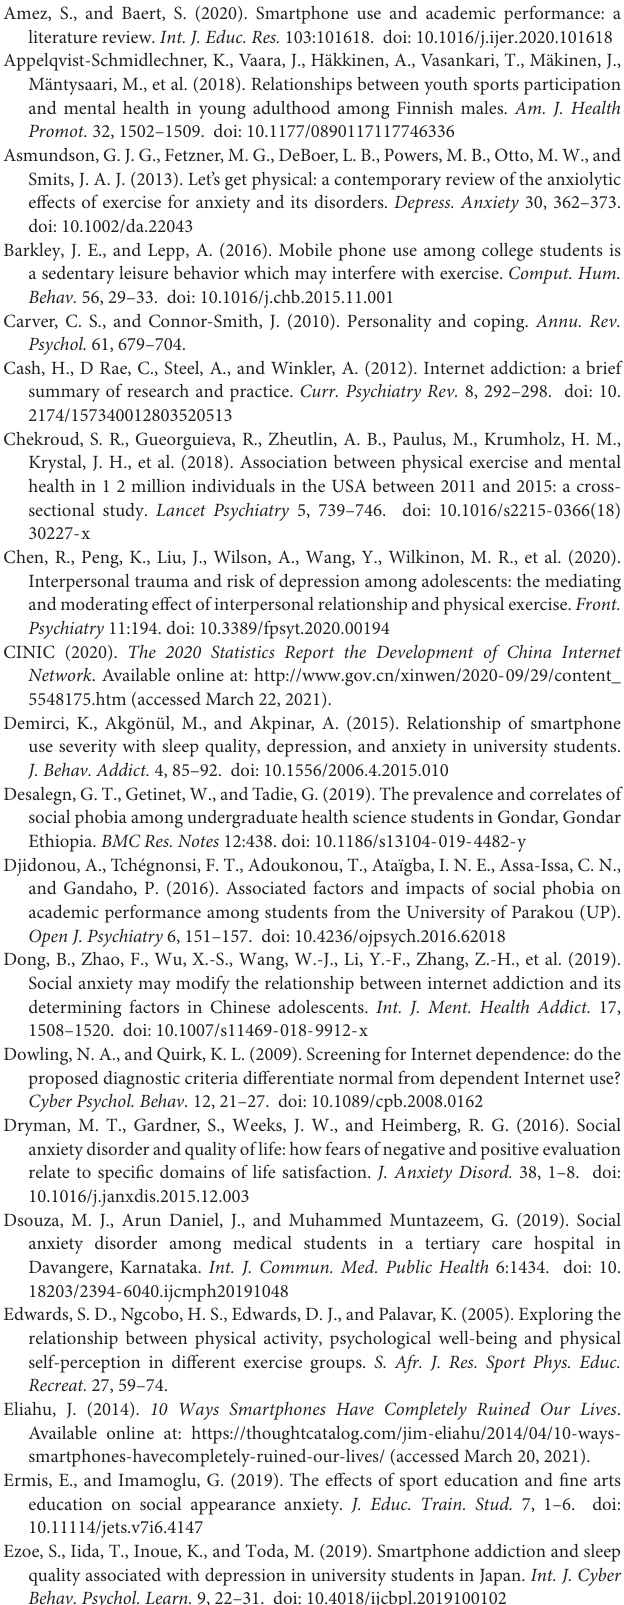
physical symptoms: moderation by physical exercise. BMC Psychiatry 20:144. doi: